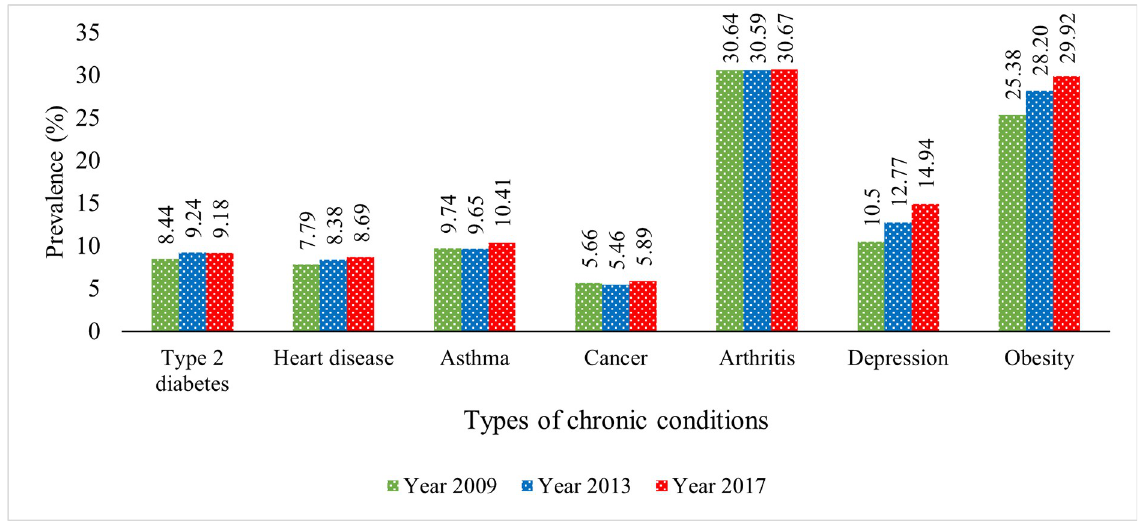
Fig 2. Prevalence of chronic conditions among middle-aged and older adults.